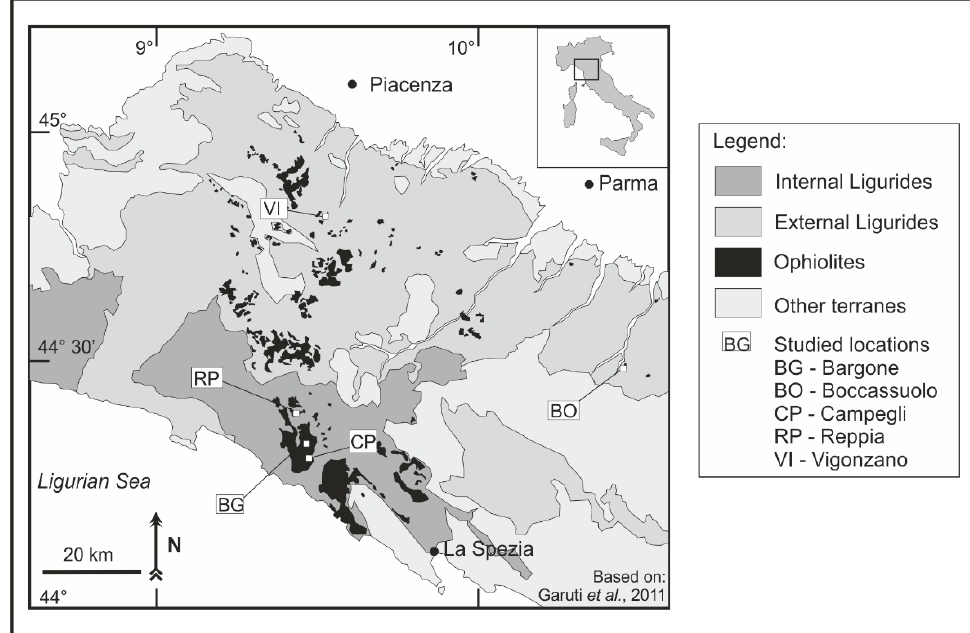
Figure 1. Structural sketch map of the External and Internal Ligurides (based on [36]) with locations of the studied Cyprus type volcanogenic massive sulfide (VMS) deposits.